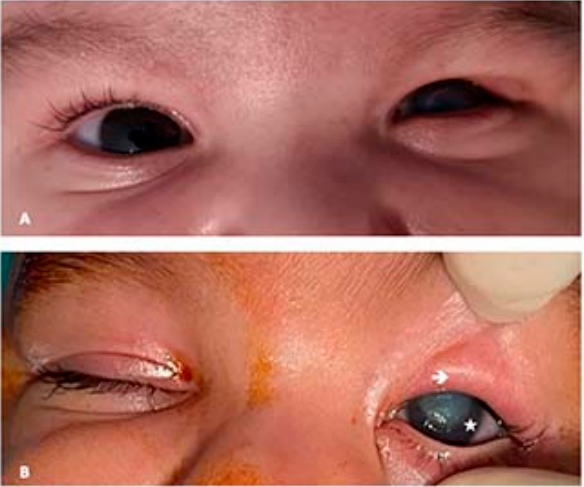
Figure 1. ( A ) Clinical aspect upon presentation. ( B ) Pre-op clinical aspect. To notice the absence of the cilia on the ciliary margin, the hypertrophy of the upper pretarsal orbicularis muscle and the central corneal leucoma (personal collection).